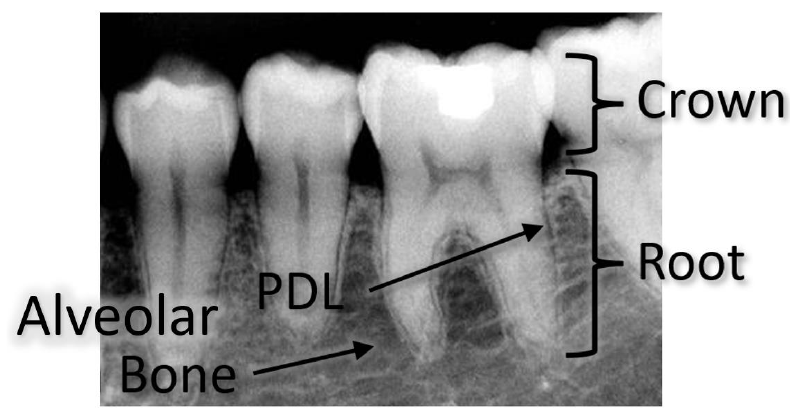
Figure 1. Tooth relevant components under X-ray imaging.